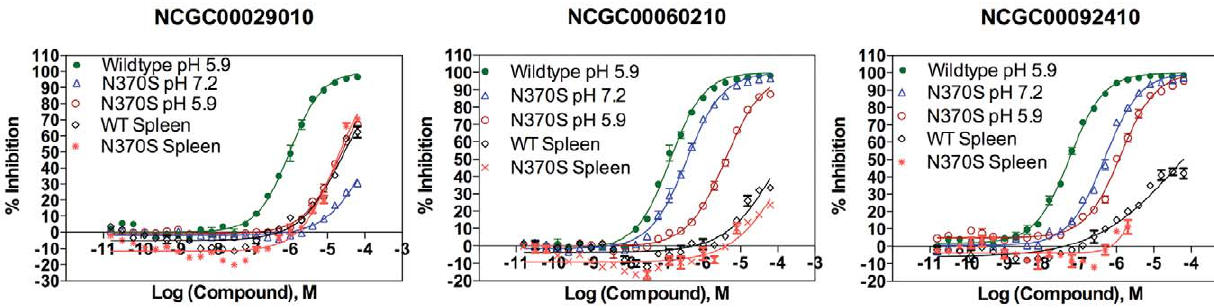
Figure 2. Concentration responses of three GCase inhibitors determined using recombinant WT GCase, recombinant N370S mutant enzyme, WT GCase from normal spleen extract and N370S mutant enzyme from a spleen of a patient with GD (genotype N370S/ N370S). The three inhibitors were identified from the previous HTS using recombinant WT GCase.